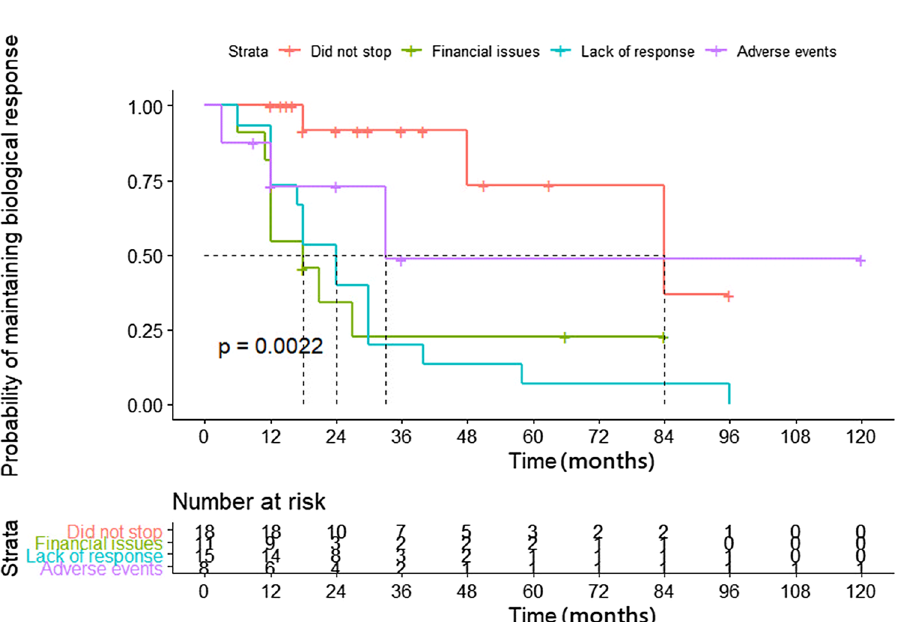
Figure 3. Kaplan Meier graph showing probability of maintaining response after anti-TNF discontinuation due to various reasons compared with patients continued to take